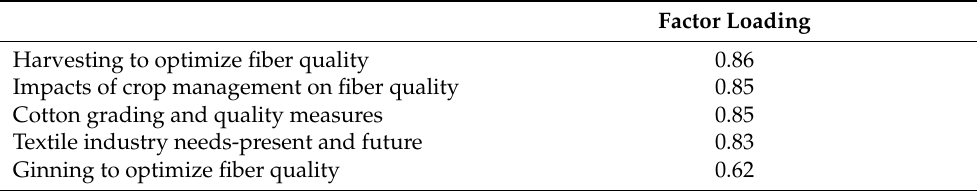
Table 21. Factor loading and proficiencies items of fiber quality and post-harvest after factor rotation.